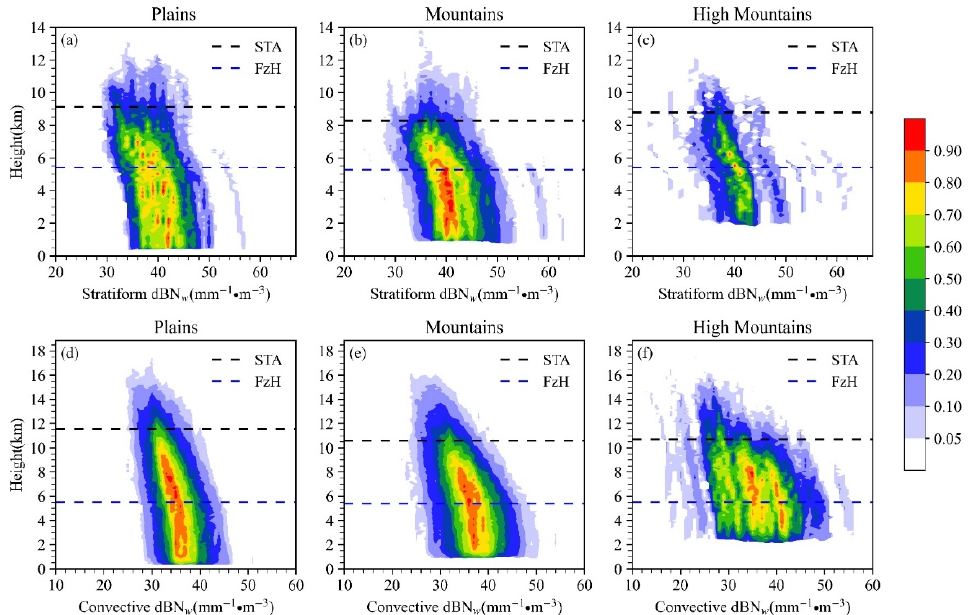
Figure 8. Normalized contoured frequency by altitude diagrams (NCFAD) of dBN w of two types of heavy precipitation over plains ( a , d ), mountains ( b , e ), and high mountains ( c , f ). The color areas indicate occurrence frequency of dBN w , the black and blue dash lines represent STA and FzH, respectively.